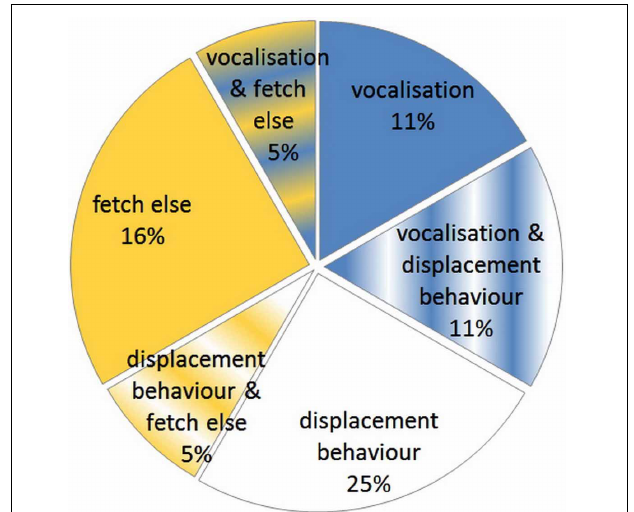
FIGURE 4 | Proportion of dogs that vocalized, exhibited displacement behaviors, fetched other objects or exhibited some combination of these behaviors when they could not find the object the owner asked